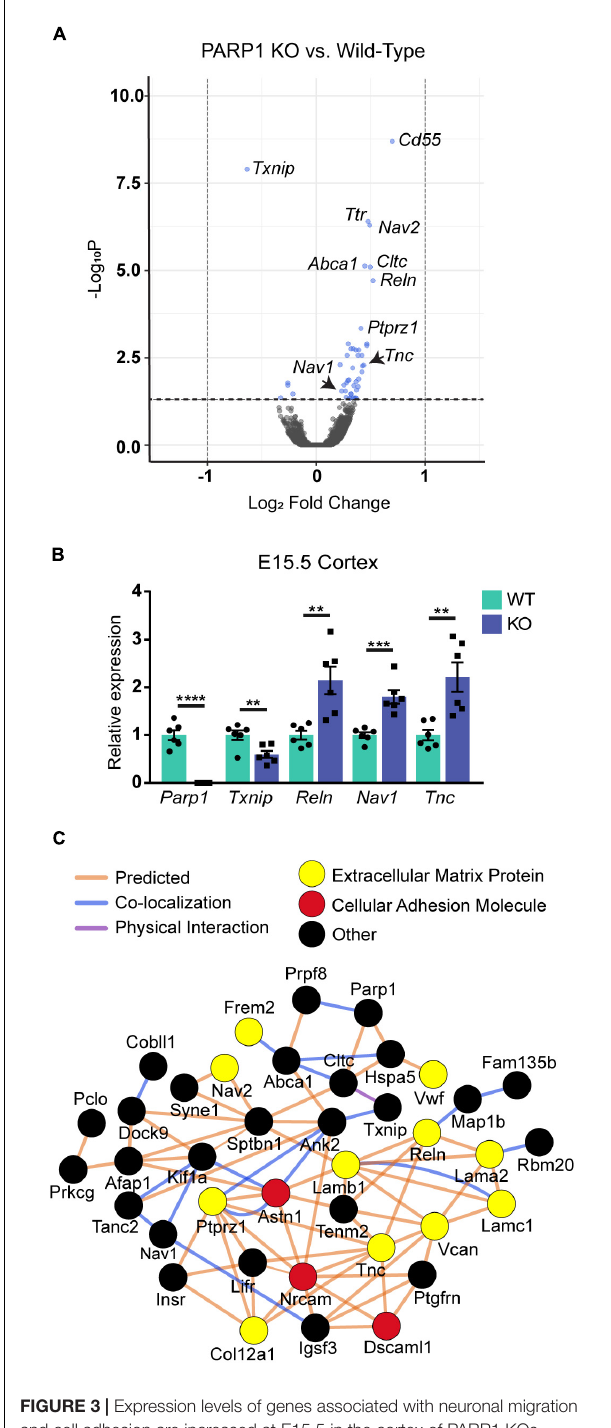
FIGURE 3 | Expression levels of genes associated with neuronal migration and cell adhesion are increased at E15.5 in the cortex of PARP1 KOs. (A) Volcano plot of the differentially expressed genes in the PARP1 KO cortex at E15.5 identified by RNA-sequencing ( n = 4 biological replicates per genotype). Genes with significantly altered expression are indicated in blue ( q -value < 0.05). Upregulated genes comprised 88% (42/48 total) of all genes exhibiting significant differential expression in KO embryonic cortex. (B) RT-qPCR validation of a subset of differentially expressed